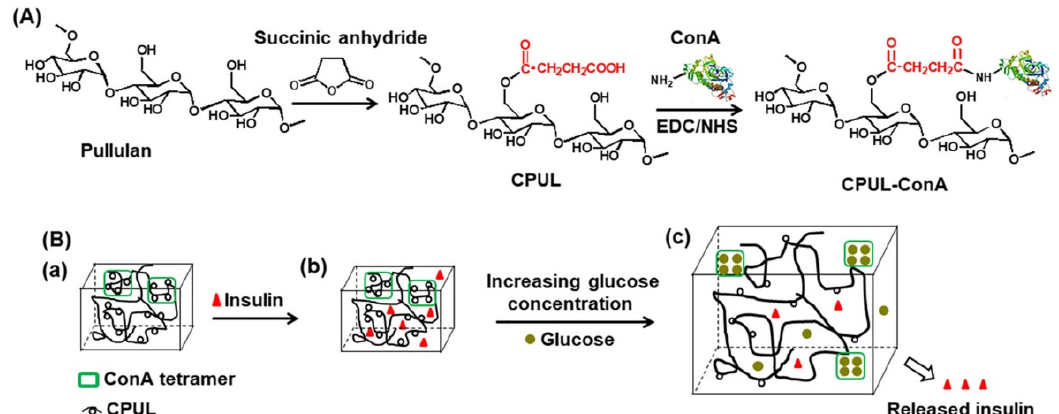
Figure 10. ( A ) Preparation of the CPUL-ConA hydrogel via EDC/NHS crosslinking. ( B ) Mechanism of controlled release of insulin from the CPUL-ConA hydrogel. ( a ) The ConA tetramer with the carboxylated Pullulan hydrogel. ( b ) Insulin drug added to the ConA-CPUL hydrogel. ( c ) Increasing glucose concentration in hydrogel environment demonstrating glucose responsiveness. Adapted with permission from [72]; Published by Elsevier, 2019.